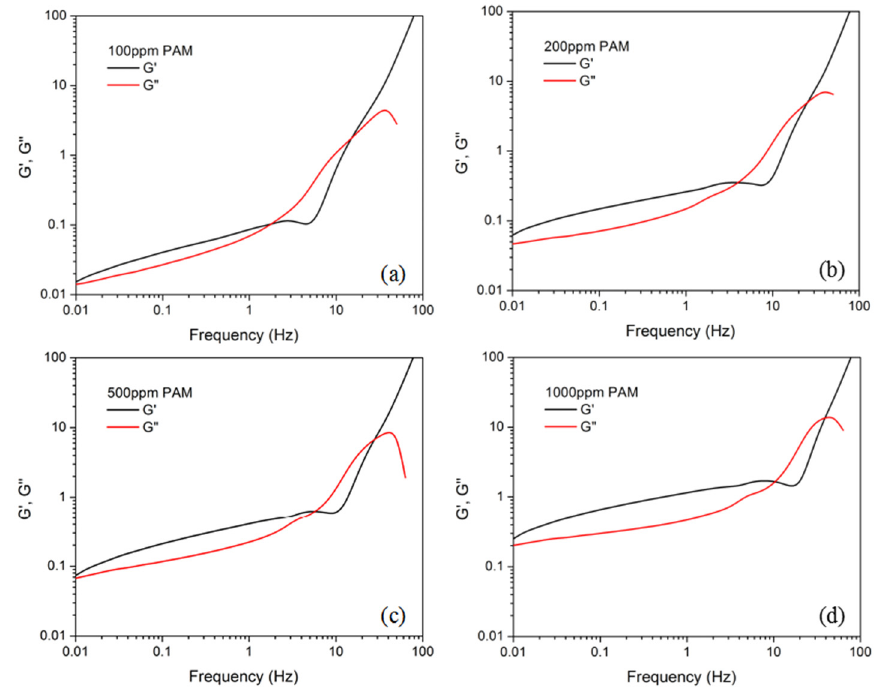
Figure 2. Complex shear modulus of the PAM solutions of ( a ) 100, ( b ) 200, ( c ) 500, and ( d ) 1000 ppm.